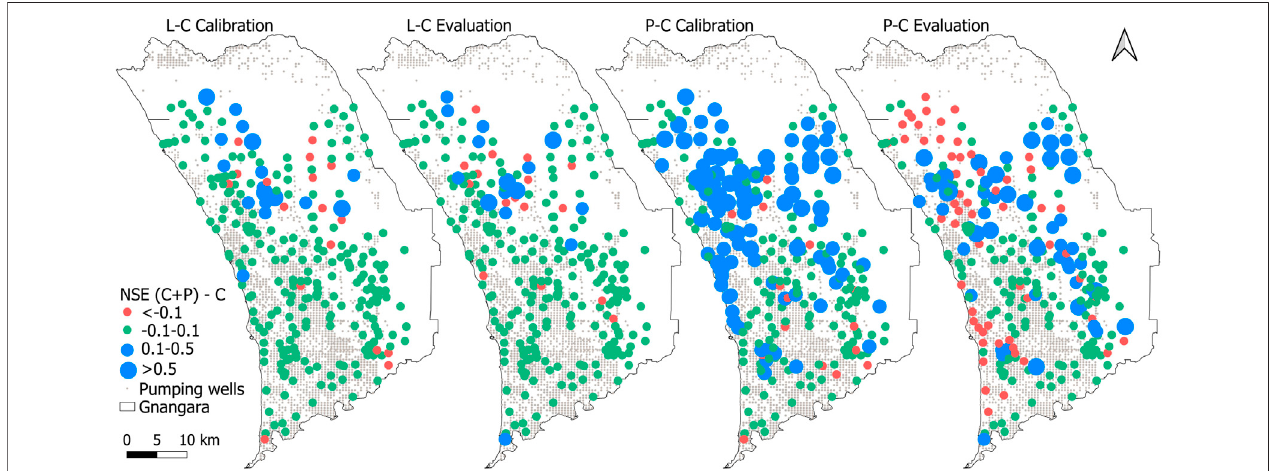
FIGURE 8 | Improvement in NSE of the climate and land cover, and the climate and pumping